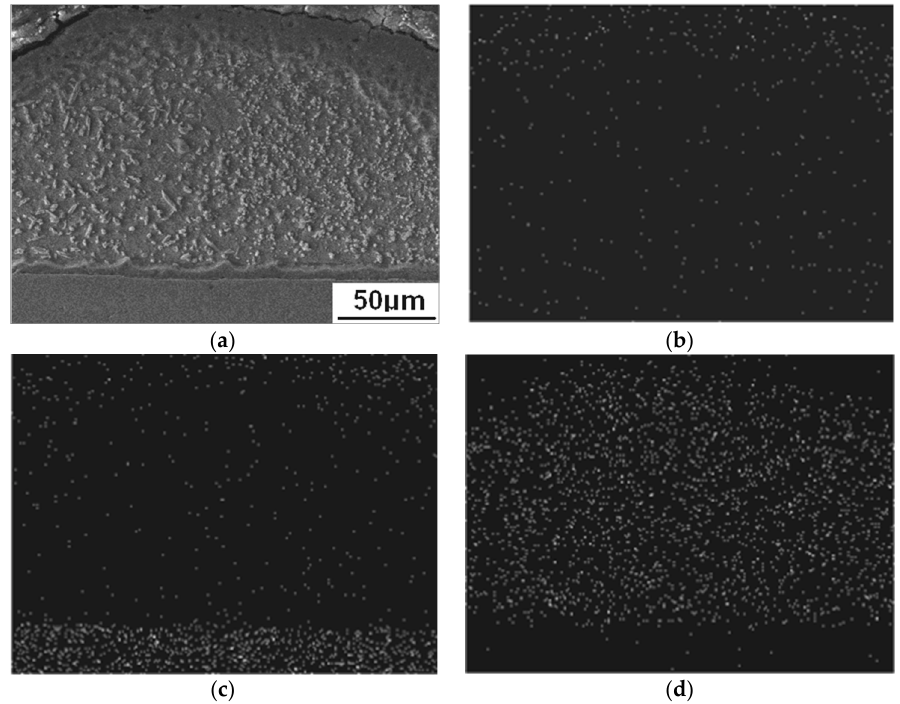
Figure 5. SEM image and element map distribution of Zn island: ( a ) SEM image; ( b ) O K α 1; ( c ) Fe K α 1; ( d ) Zn K α 1.